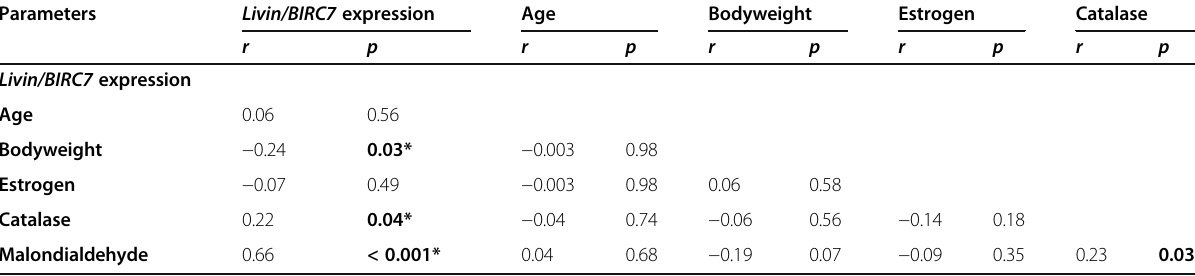
Table 3 Pearson ’ s correlation analysis among all the studied parameters Parameters